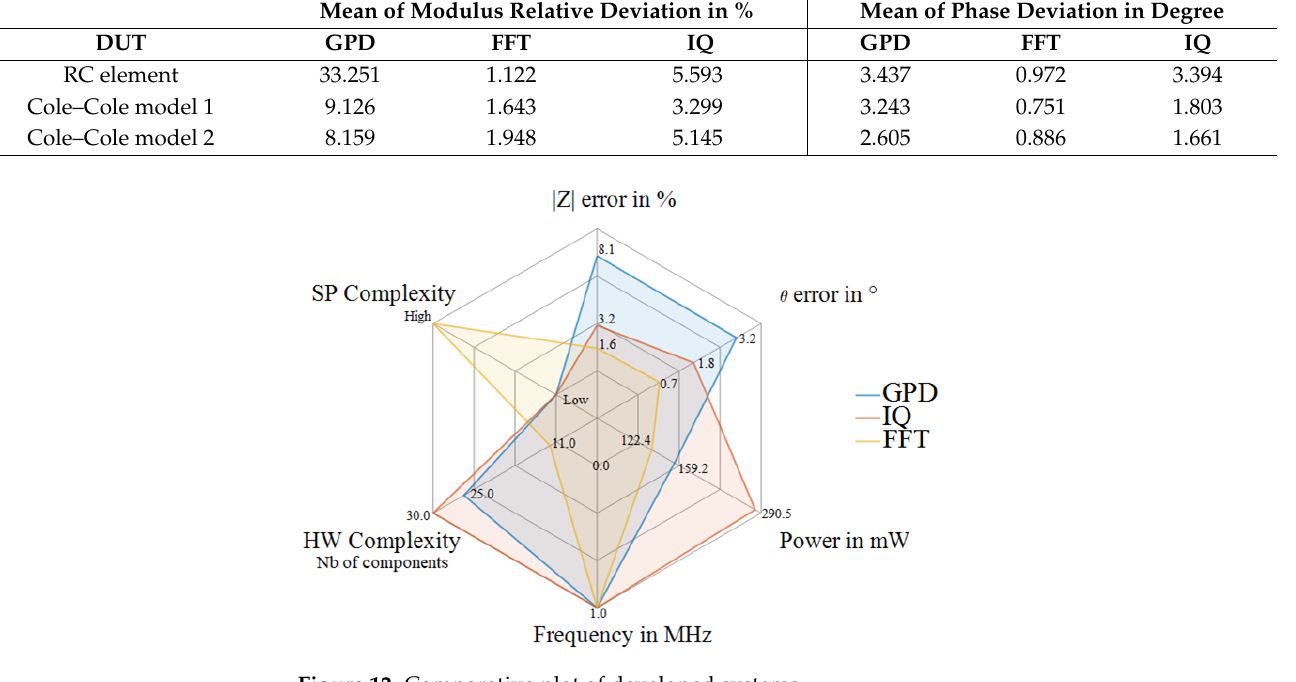
Figure 12. Comparative plot of developed